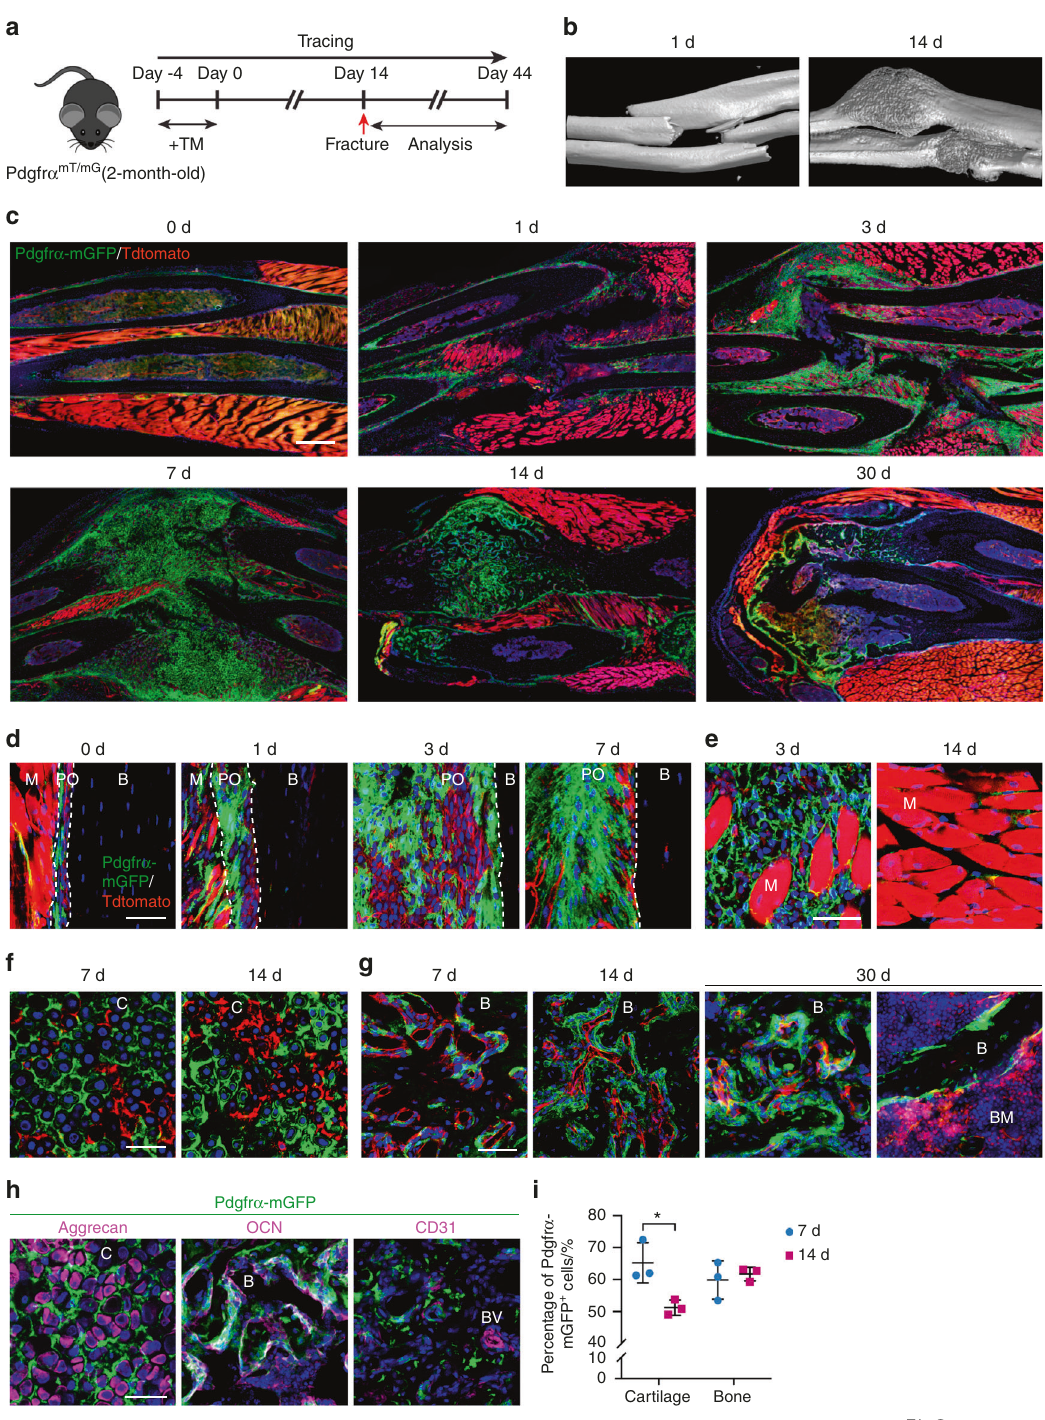
Fig. 2 PDGFR α reporter + periosteal cells give rise to osteochondral cells within a fractured callus. a PDGFR α mT/mG reporter animals (male, aged 2 mo) were administered TM, forelimb fracture was performed after 14 d, and an analysis was performed 1 – 30 d later. b Micro-CT 3D reconstructions at representative time points after fracture. c Representative tile scans of the whole forelimb at serial time points after fracture ranging from 0 to 30 d. The uninjured forelimb is shown for comparison. Nuclei, DAPI (4 ′ ,6-diamidino-2-phenylindole, blue). d Representative high-magni fi cation images of PDGFR α reporter activity in the periosteum of unfractured or fractured bone (d 1 – 7). e High-magni fi cation images of GFP + cells in skeletal muscle adjacent to the fracture site (3 and 14 d). The dashed lines indicate the limit between the periosteum and muscle or bone. f Contribution of GFP + cells in the cartilage of the fractured callus (7 and 14 d). g Contribution of GFP + cells to new osteoblasts in the fractured callus (7 – 30 d). h Representative immunohistochemical staining of a PDGFR α mT/mG fractured callus was performed 7 or 14 d after injury, including staining for aggrecan, osteocalcin (OCN), and CD31. i Percentages of mGFP + chondrocytes/total chondrocytes and mGFP + osteoblasts/total osteoblasts assessed at 7 and 14 d after injury. B bone, BM bone marrow, BV blood vessel, C cartilage, M skeletal muscle, PO periosteum. Scale bars: 500 μ m ( c ) and 50 μ m ( d – h ). n = 3 animals per group. The dot plots represent an individual animal, and the whisker plots indicate the mean and one-SD values. * P < 0.05, as assessed by two-tailed Student ’ s t